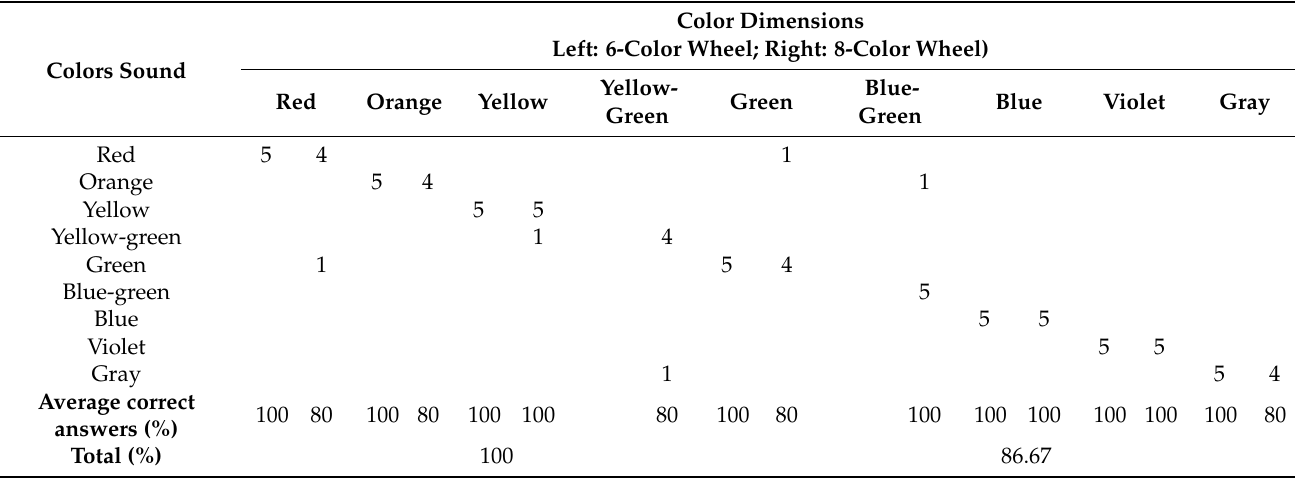
Table 8. Six-color wheel and eight-color wheel code identification test in experiment 1 (color).